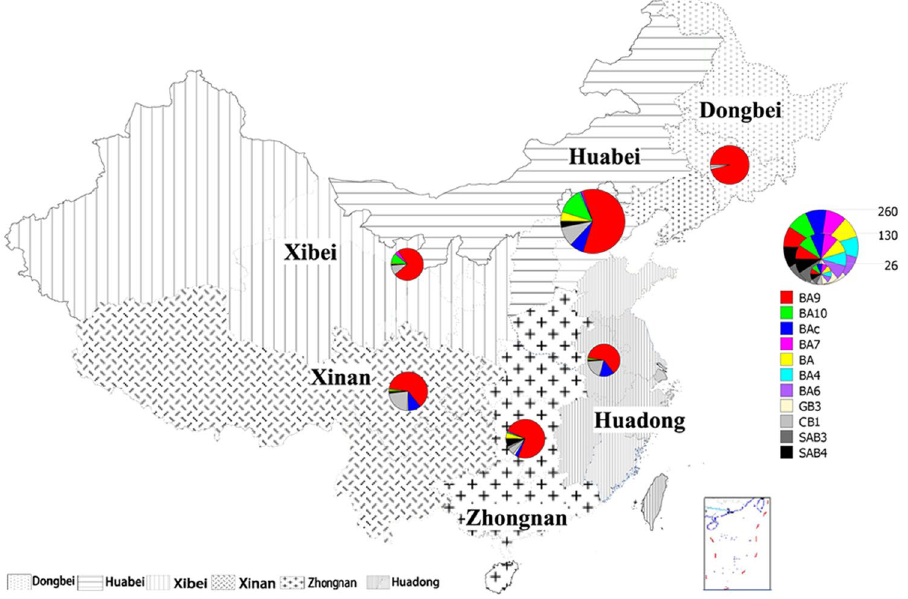
Figiure 1. Geographic distribution of HRSVB samples in 6 representative regions of China. The region and the number of sequences are colored according to the legend. The map was constructed using Mapinfo Professional software, Version 11.0 (http://www.pitneybowes.com/us/location-intelligence/geographic-information-